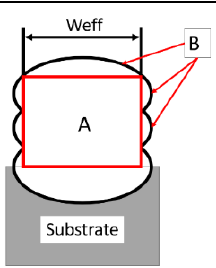
Figure 1. Diagram of multilayer specimen where A = effective wall area, Weff = effective wall thickness and B = overbuild material mass.